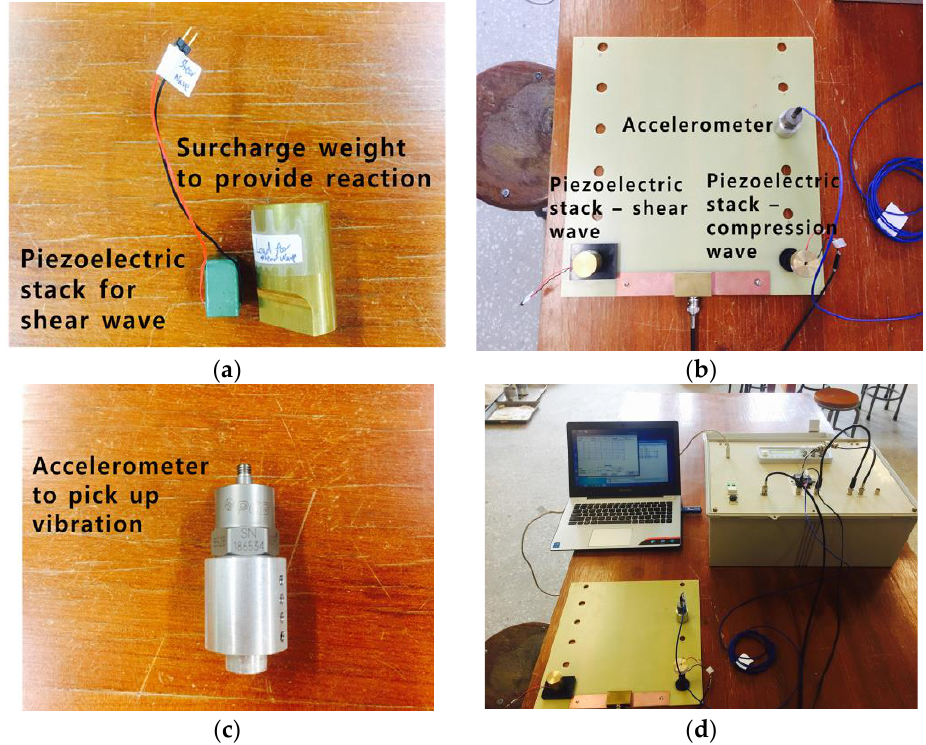
Figure 7. Shear wave velocity measurement: ( a ) Piezoelectric stack for shear wave and weight; ( b ) Accelerometer to pick up vibration; ( c ) Combined component; ( d ) The whole view of the TDR system. (Song, [12]).